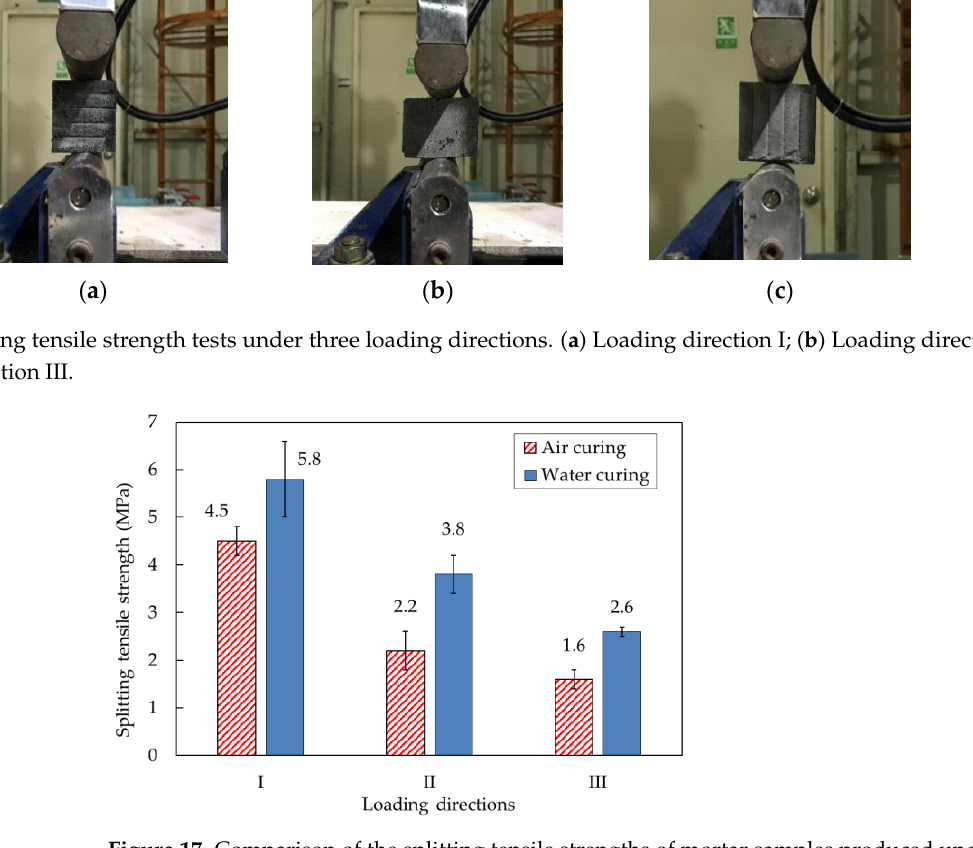
Figure 17. Comparison of the splitting tensile strengths of mortar samples produced under different curing conditions.